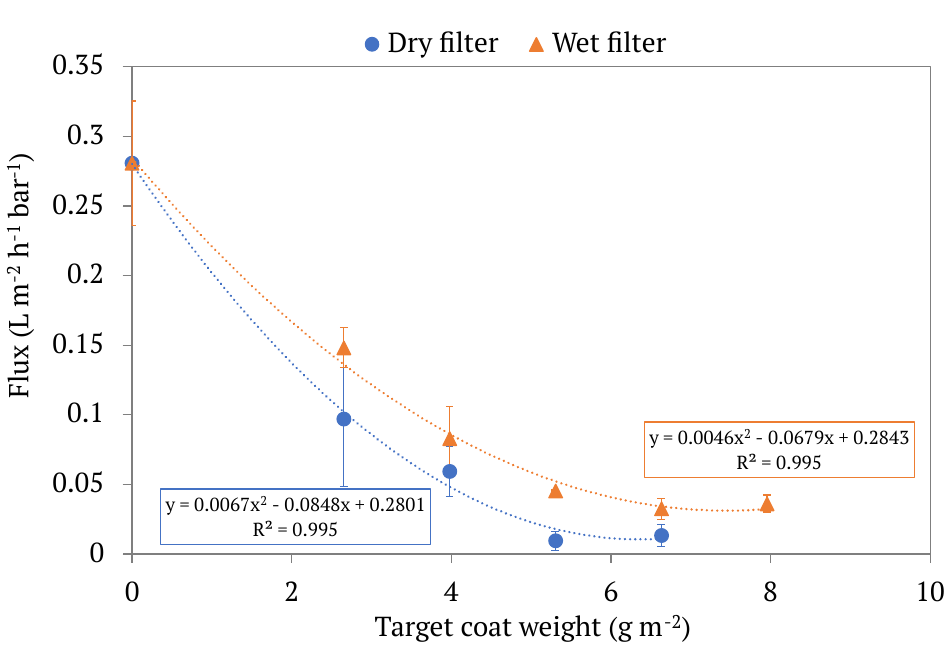
Figure 6. The flux values, calculated by Equation (1), of different LCNF-modified filters by coat weight. Both dry and wet filters are displayed, each set with its own respective trendline. Each point represents the average flux of multiple trials of modified filters with the same target coat weight, with the standard deviations of said values being displayed in the error bars.